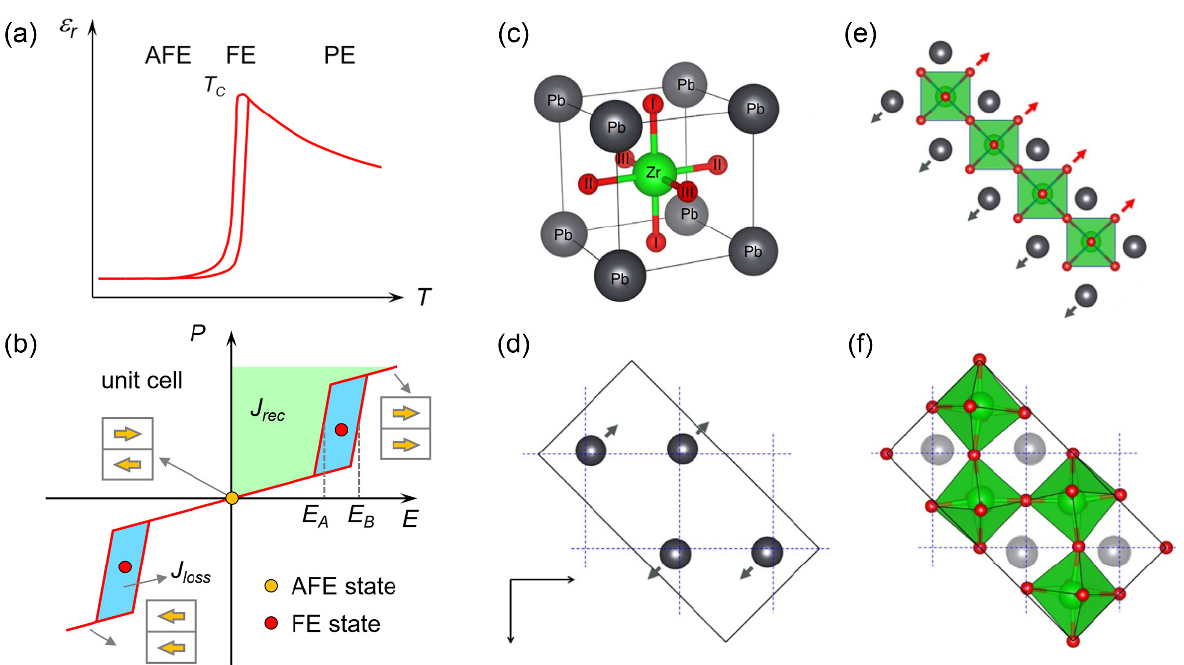
Figure 2. Dielectric constant ( ε r ), P-E loop and structural phases of PbZrO 3 . ( a,b ) Temperature-dependent ε r and hysteresis loop of AFEs. The green and blue shaded areas in ( b ) denote recoverable (J rec ) and loss (J loss ) energy during the AFE-to-FE transition. ( c ) Unit cell of the cubic PbZrO 3 phase (space group Pm3m). ( d–f ) Antiparallel Pb displacements ( Σ mode), polar displacement ( Γ mode) and oxygen octahedral rotations (R mode) in AFE PbZrO 3 (space group Pbam ), respectively. The dotted lines show the cubic crystallographic axes in the ab plane